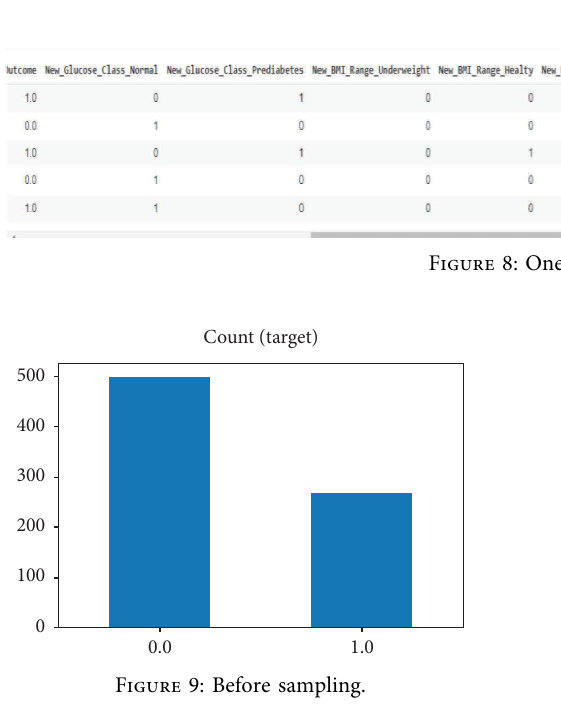
Figure 9: Before sampling.